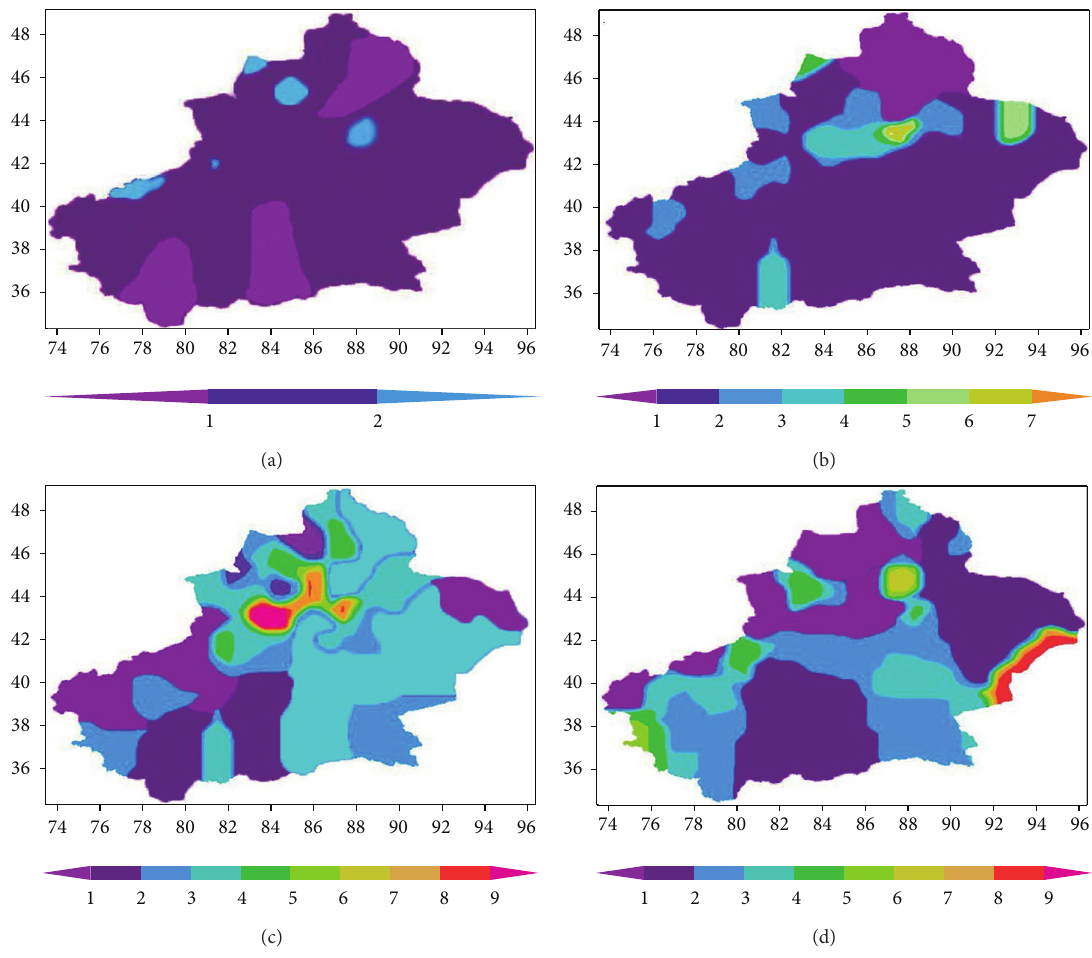
Figure 3: Frequencies exceeding indicated thresholds (1985–2008/1961–1984).